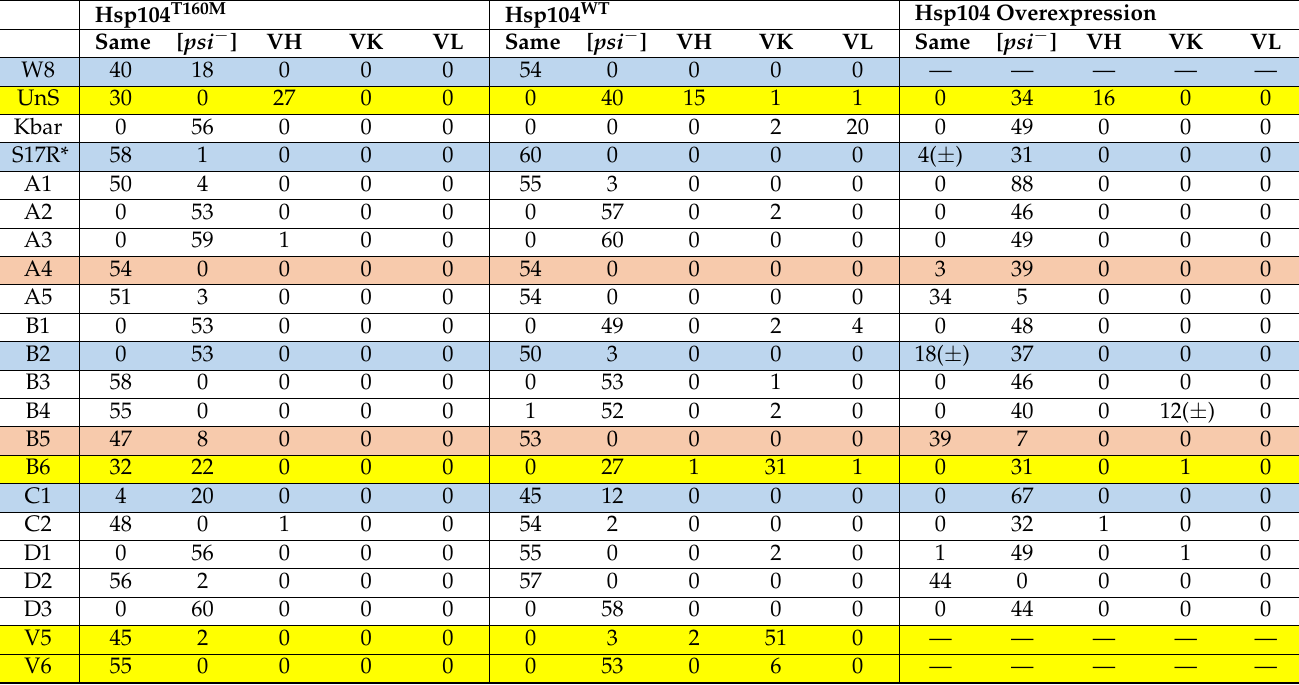
Same: the same type as the donor. VH, VK, and VL: cytoductants propagating VH, VK, and VL, respectively, which were the only mis-templated variant types observed at this stage. ( ± ): colonies containing a significant proportion of [ psi − ] cells. –: not done. Hsp104 was expressed from the native promoter; overexpression was achieved by transformation with a multi-copy plasmid carrying the Hsp104 gene. Blue: faithful propagating variants. Yellow: transmutable but stabilized in T160M cells. Red: transmutable but stabilized in wild-type cells. The classification uses additional data from Tables 2–4 as well as Table 3 of reference [18]. A2, A3, B1, and